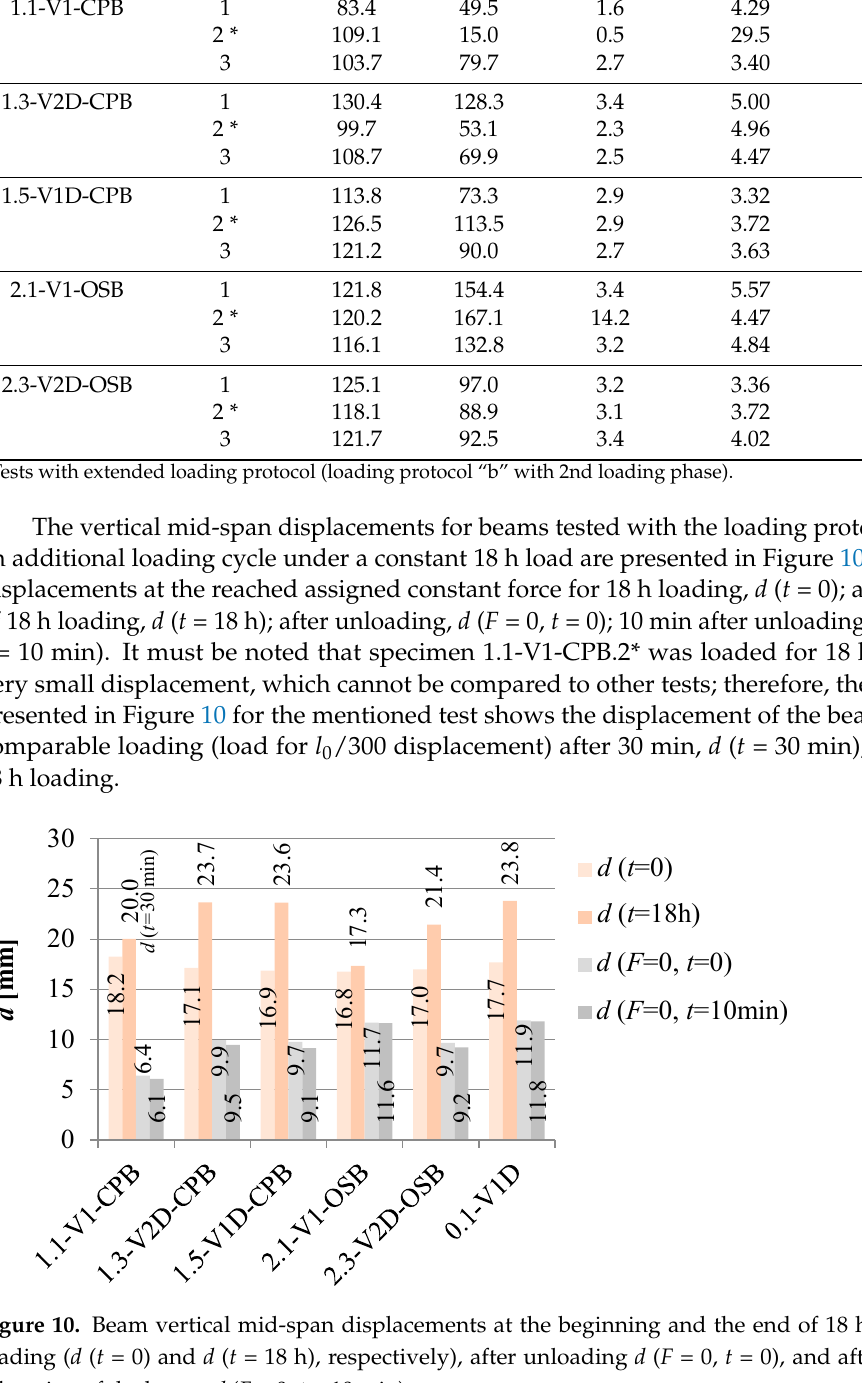
Table 2. Results of experimental bending tests.